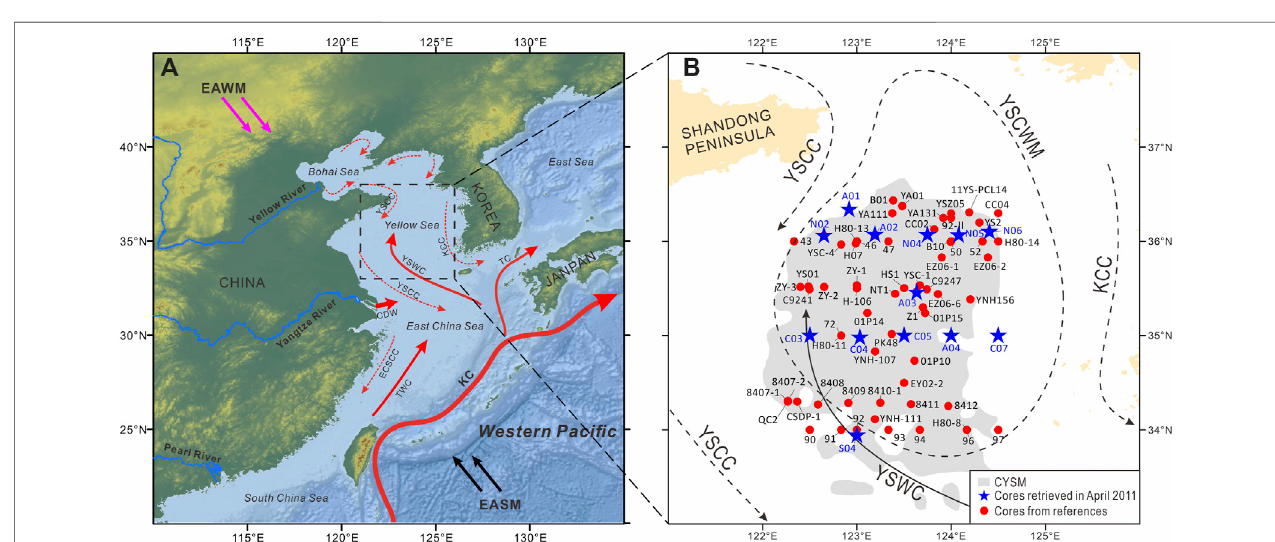
FIGURE1| Modernoceanographicsettingandlocationsofcores. (A) Schematicbathymetryandoceaniccirculation(winter)oftheEastChinaSea. (B) Schematic chart of regional circulation of the Southern Yellow Sea and the geographic locations of sediment cores discussed in this study. Blue stars and red dots indicate cores retrieved in April 2011 and cores taken from references, respectively ( Table 1 ). The Central Yellow Sea Mud (CYSM) zone modi fi ed from (Li G. et al., 2014) and (Yang et al.,2018).Theoceaniccirculationwasrevisedafter(SuandYuan,2005)and(KimandKennett, 1998).KC,KuroshioCurrent;YSWC,YellowSeaWarmCurrent; TWC, Taiwan Warm Current; TWC, Tsushima Warm Current; YSCC, Yellow Sea Coastal Current; KCC, Korea Coast Current;ECSCC, East ChinaSea Coastal Current; CDW, Changjiang (Yangtze River) Diluted Water; YSCWM, Yellow Sea Cold Water Mass.